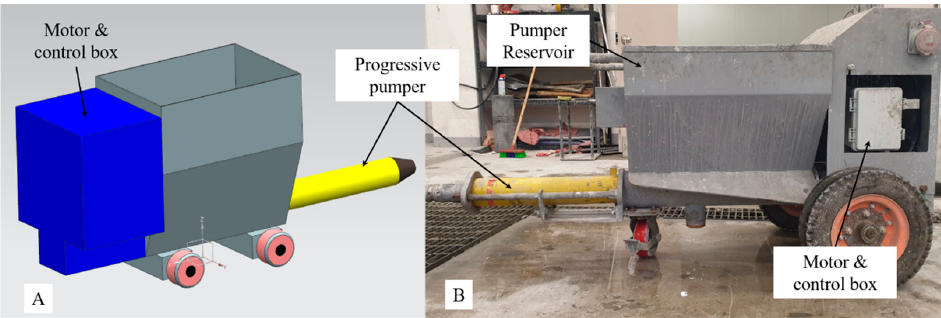
Figure 3. The pumping equipment of 3DCP system: ( A ) concept model; ( B ) developed machine.